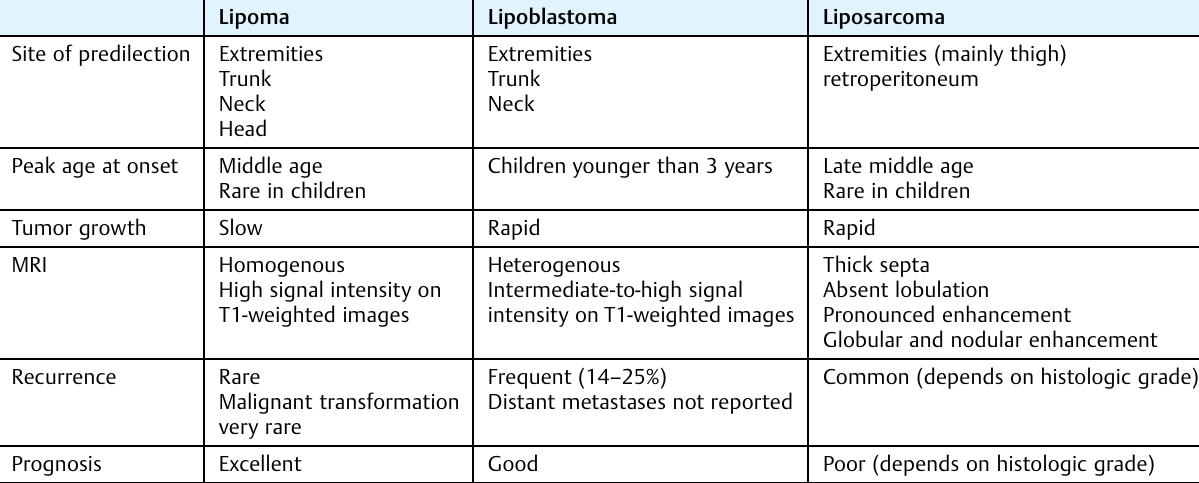
Extremities (mainly thigh) retroperitoneum Rare in children Thick septa Absent lobulation Pronounced enhancement Globular and nodular enhancement Common (depends on histologic grade)